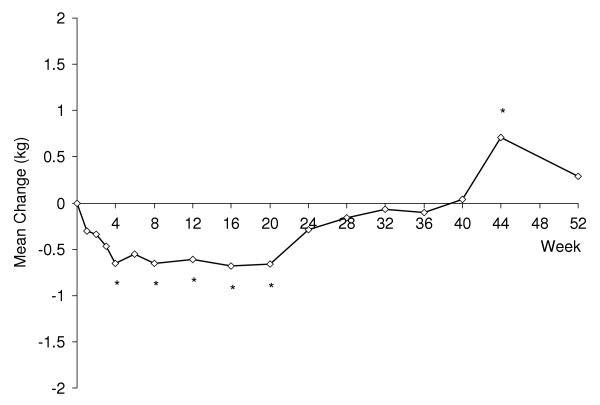
Mean change in weight (kg) for duloxetine-treated patients aged ≥ 65 years (dose 80–120 mg/d, n = 98). *p ≤ .05 from t-test for mean change.